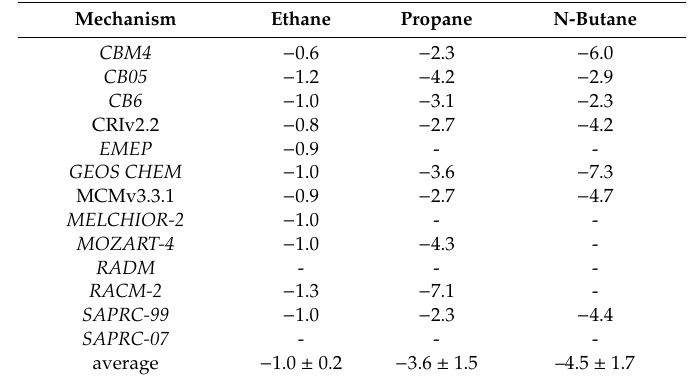
Table 3. Initial a hydroxyl radical incremental reactivities for the alkanes in units of 10 6 molecule cm − 3 per ppb hour − 1 .